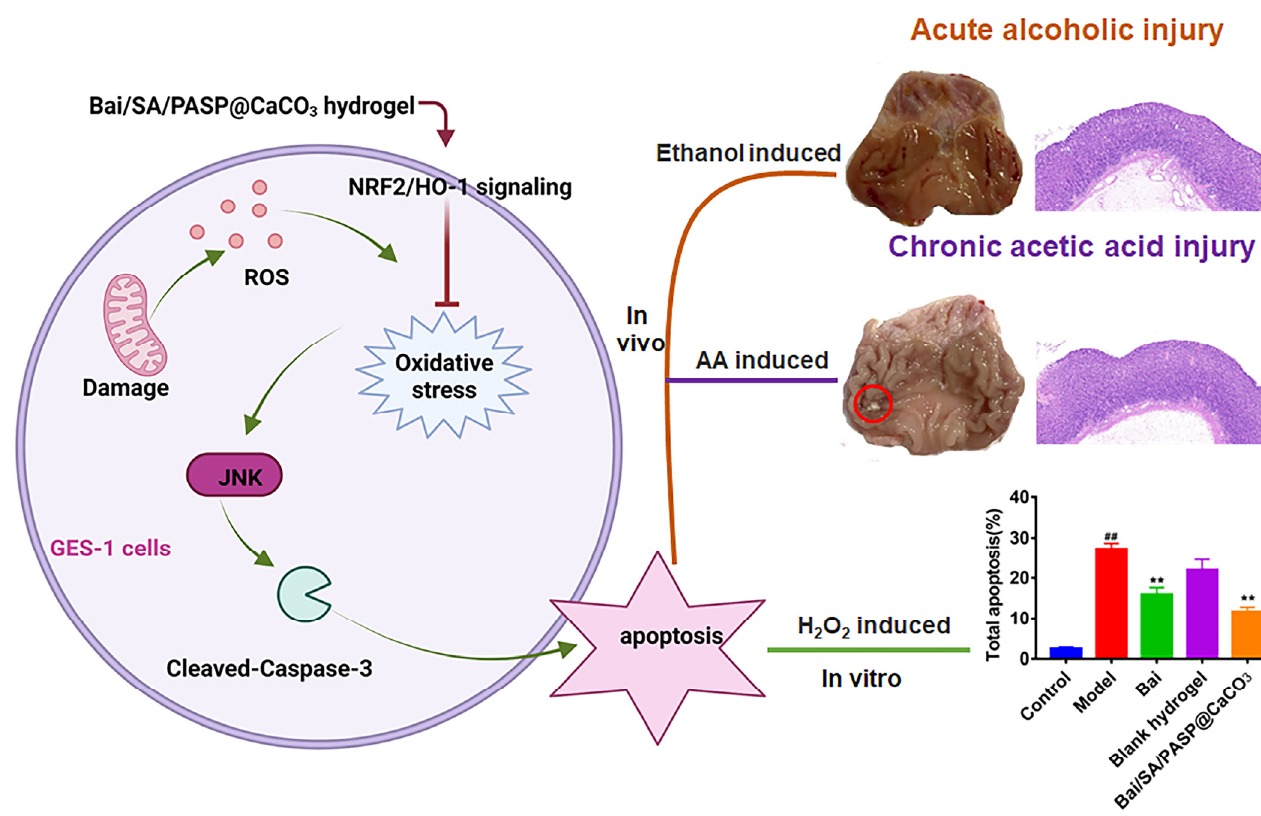
Scheme 1. Illustration of Bai-loaded SA/PASP@CaCO 3 hydrogel applied for the treatment of three GU models by inhibiting oxidative stress through the NRF2/HO-1 signaling pathway. Significant difference from the control group: ## p < 0.01; Significant difference from the model group: ** p < 0.01.